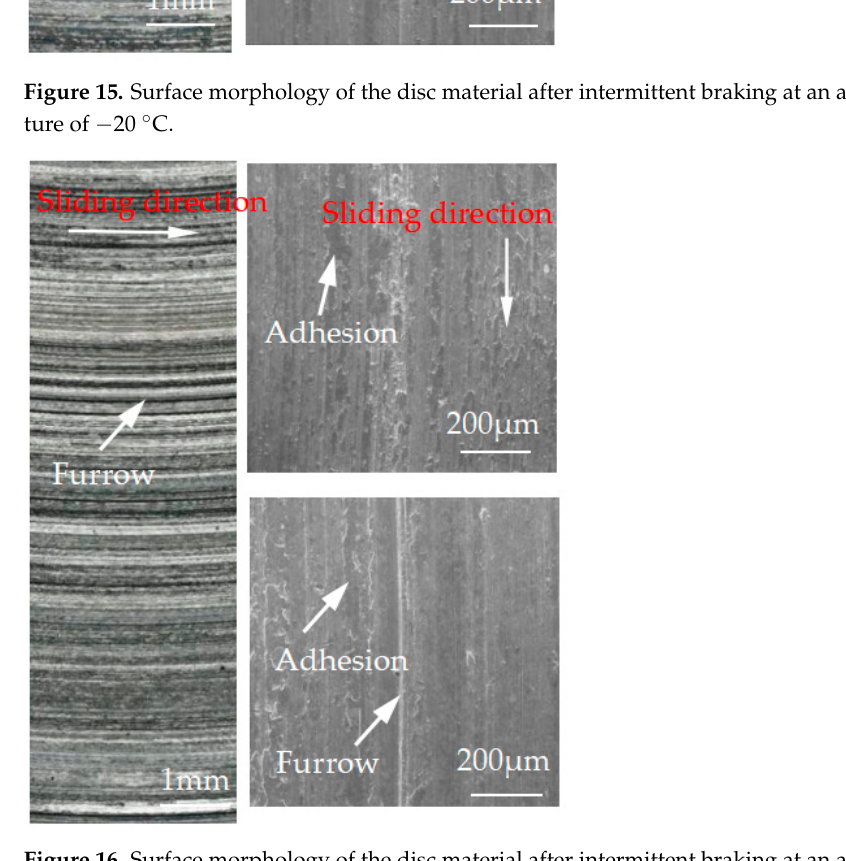
Figure 16. Surface morphology of the disc material after intermittent braking at an ambient temperature of − 30 °C.